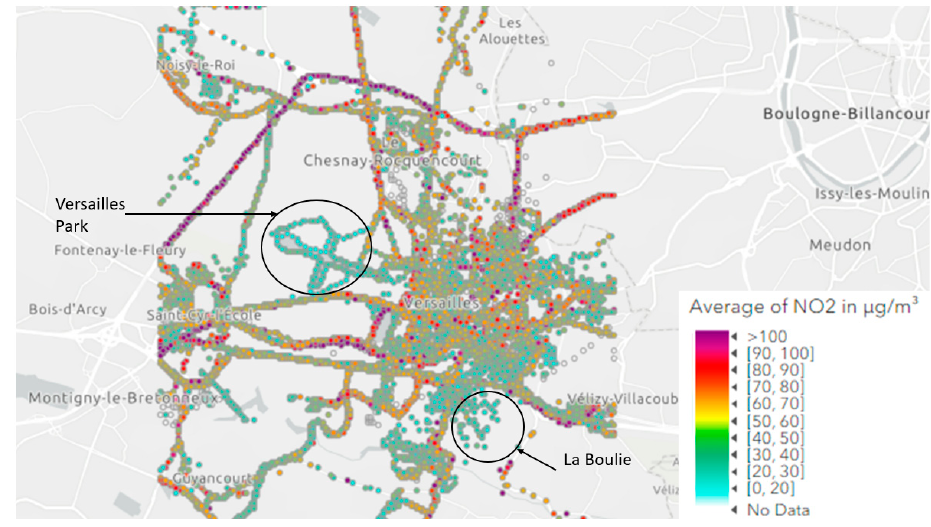
Figure 4. Geo-located NO 2 concentration in Versailles.